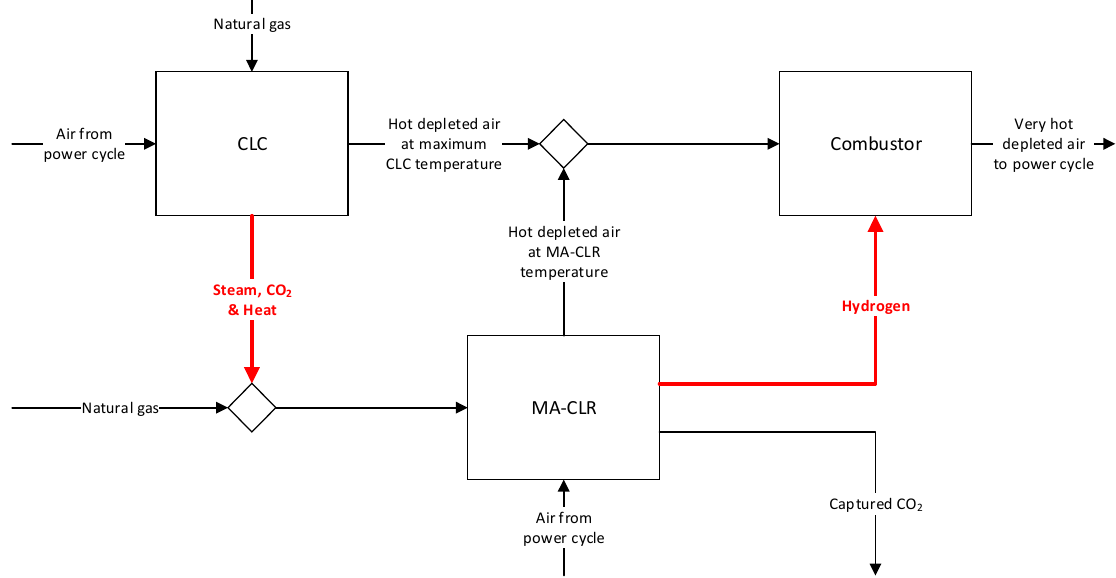
Figure 1. Simplified illustration of the working principle behind the plants described in this study.